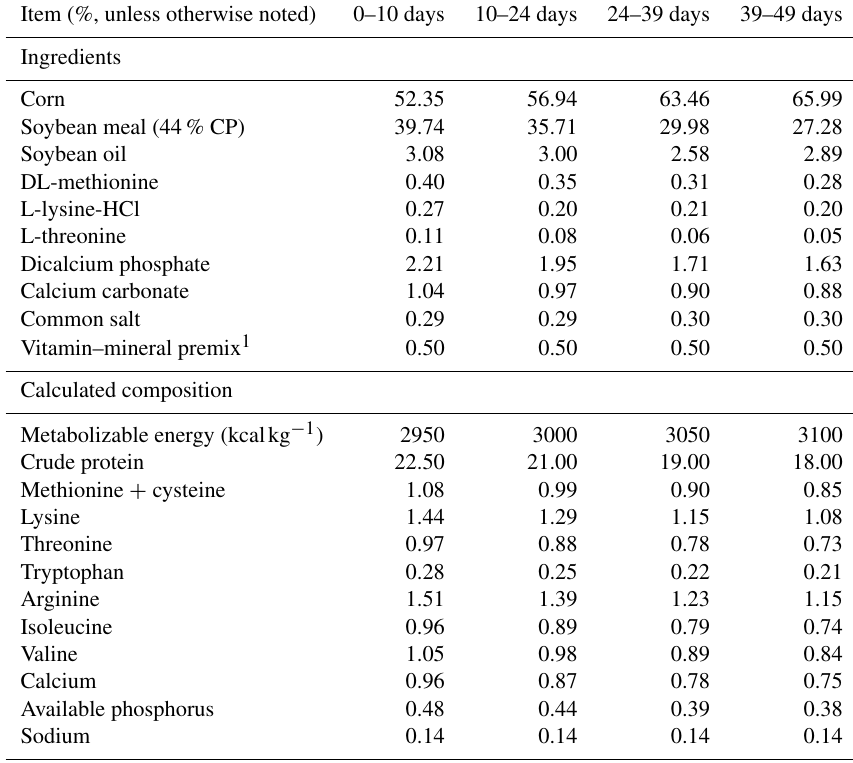
Table 1. Ingredients and nutrients level of the basal diets at different periods of experiment. Item (%, unless otherwise